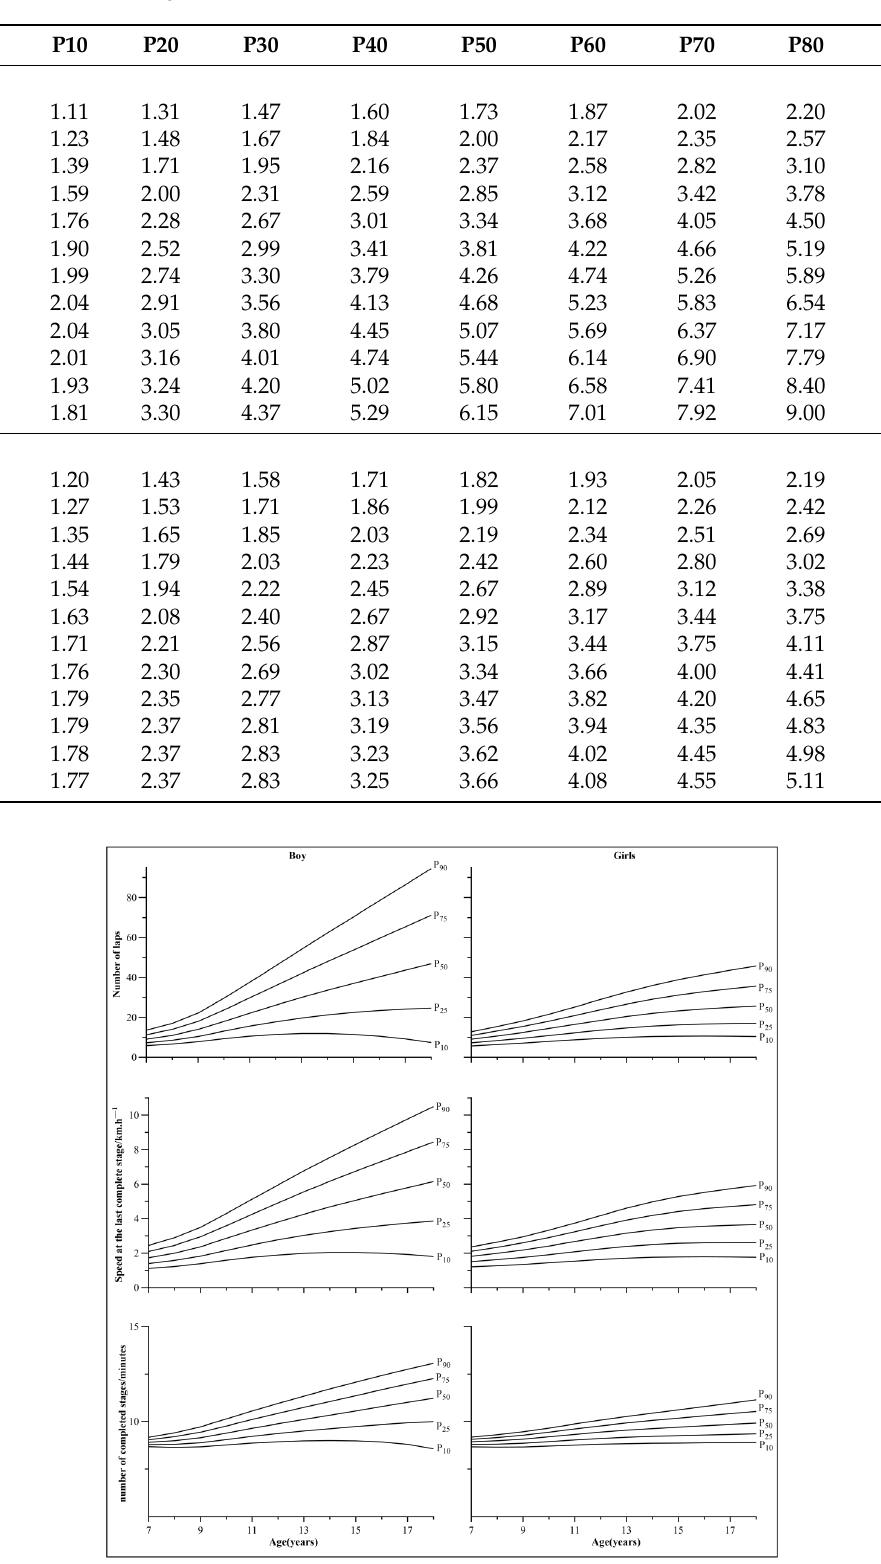
Table 2. Percentile values of the completed stages/minutes for Chinese Tibetan children and adoles- cents aged 7–18 in Tibet, China.